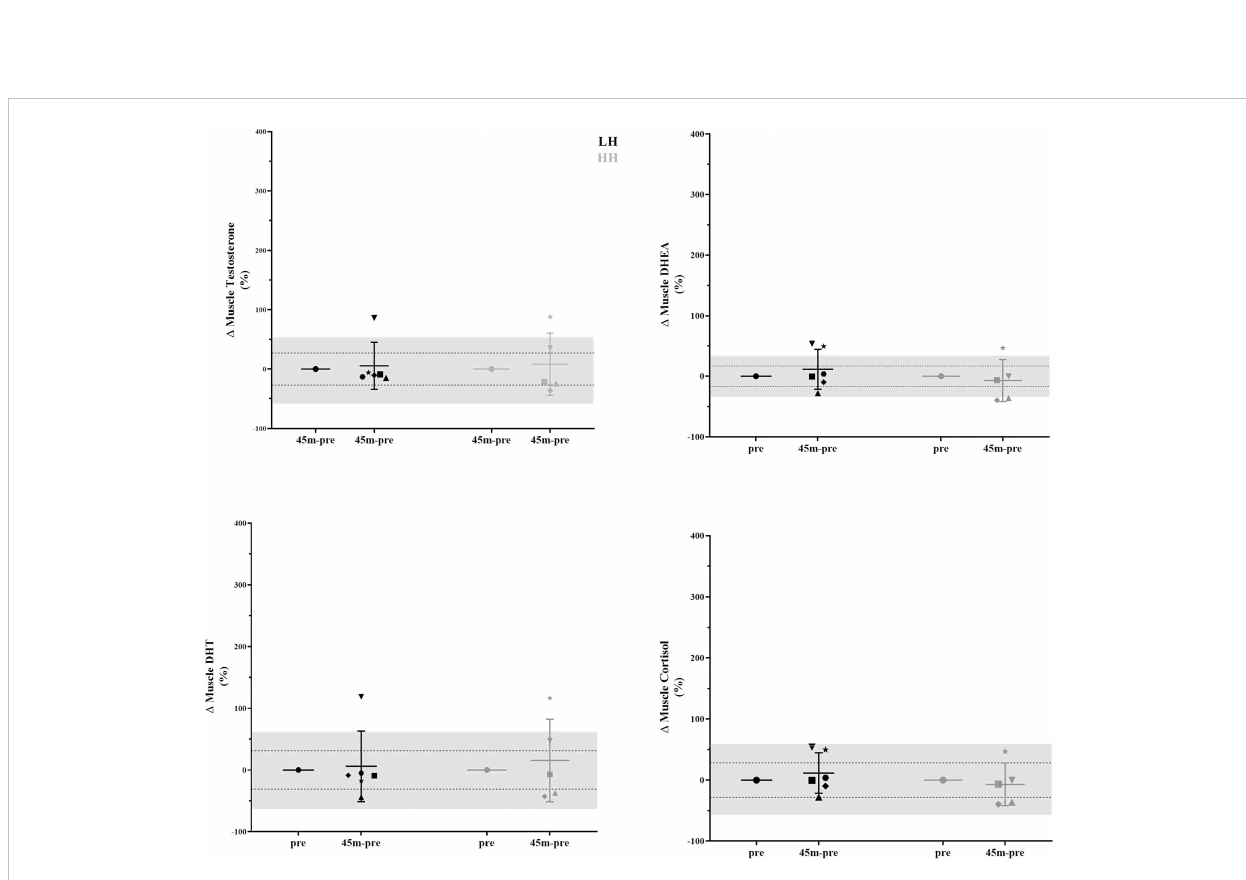
FIGURE 3 Delta changes in serum steroid concentrations pre-LH and HH protocols and at 15 min and 30 min postexercise. The gray area represents two times the typical error (positive and negative), and the dotted lines represent the typical error (positive and negative). Each symbol represents one subject.